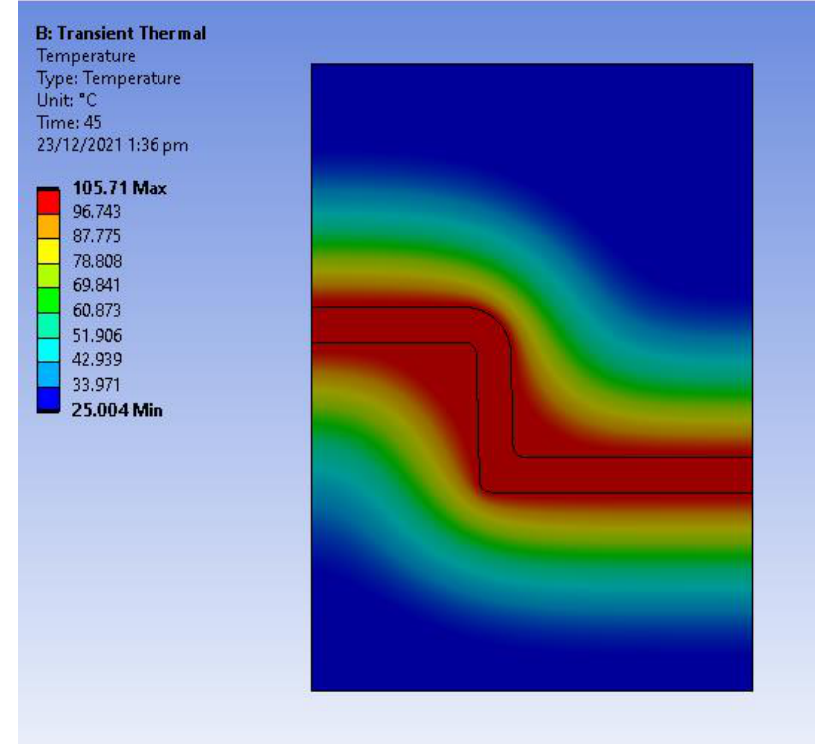
Figure 10. Temperature distribution at the end of the cooling stage (45 s).